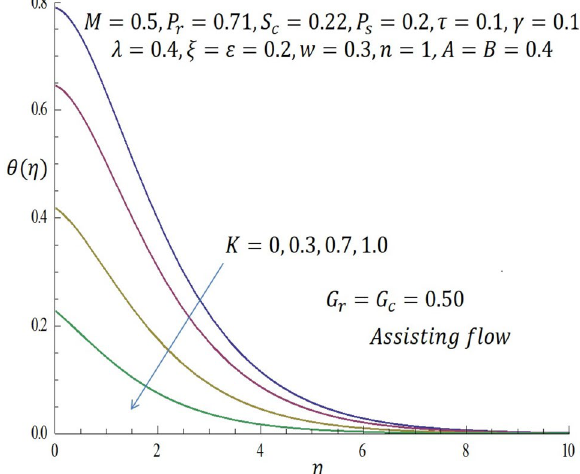
Figure 3. Effect of K on temperature profile when G r = G c = 0.5.